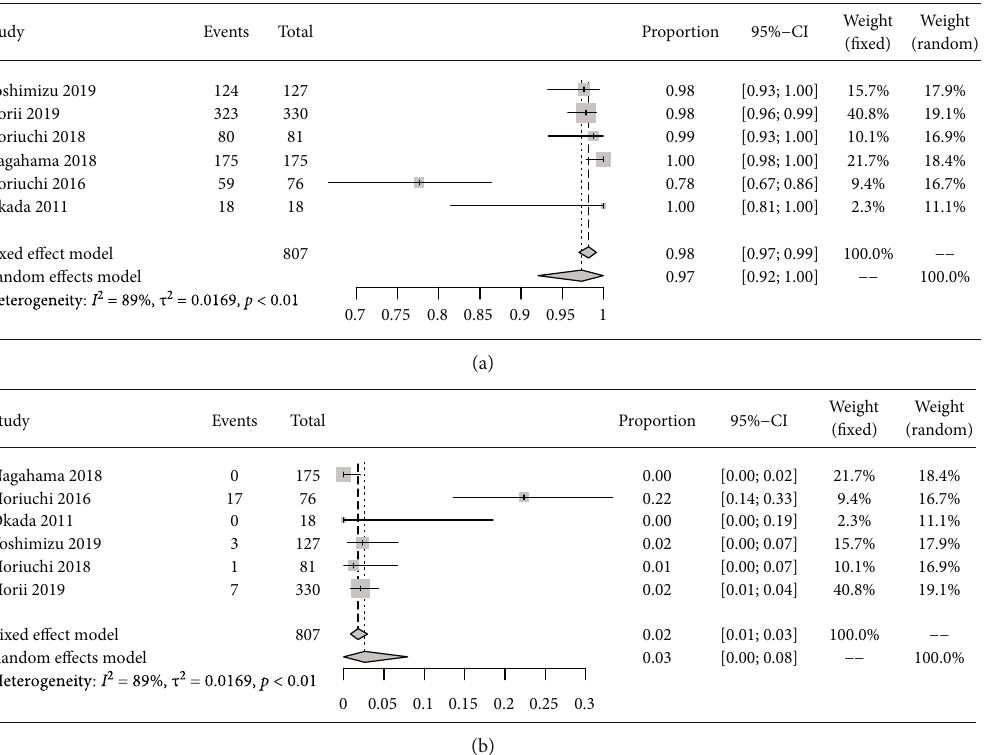
Figure 3: The negative and positive resection rates of HM of EGC after ESD and surgery. (a) The negative resection rates of HM of EGC after ESD and surgery. (b) The positive resection rates of HM of EGC after ESD and surgery. HM: horizontal margin; EGC: early gastric cancer; ESD: endoscopic submucosal dissection. Table 3: The negative resection rate of the horizontal margin in di ff erentiated-type EGC and undi ff erentiated-type EGC. Number of studies n (lesions examined) Events (lesions examined)